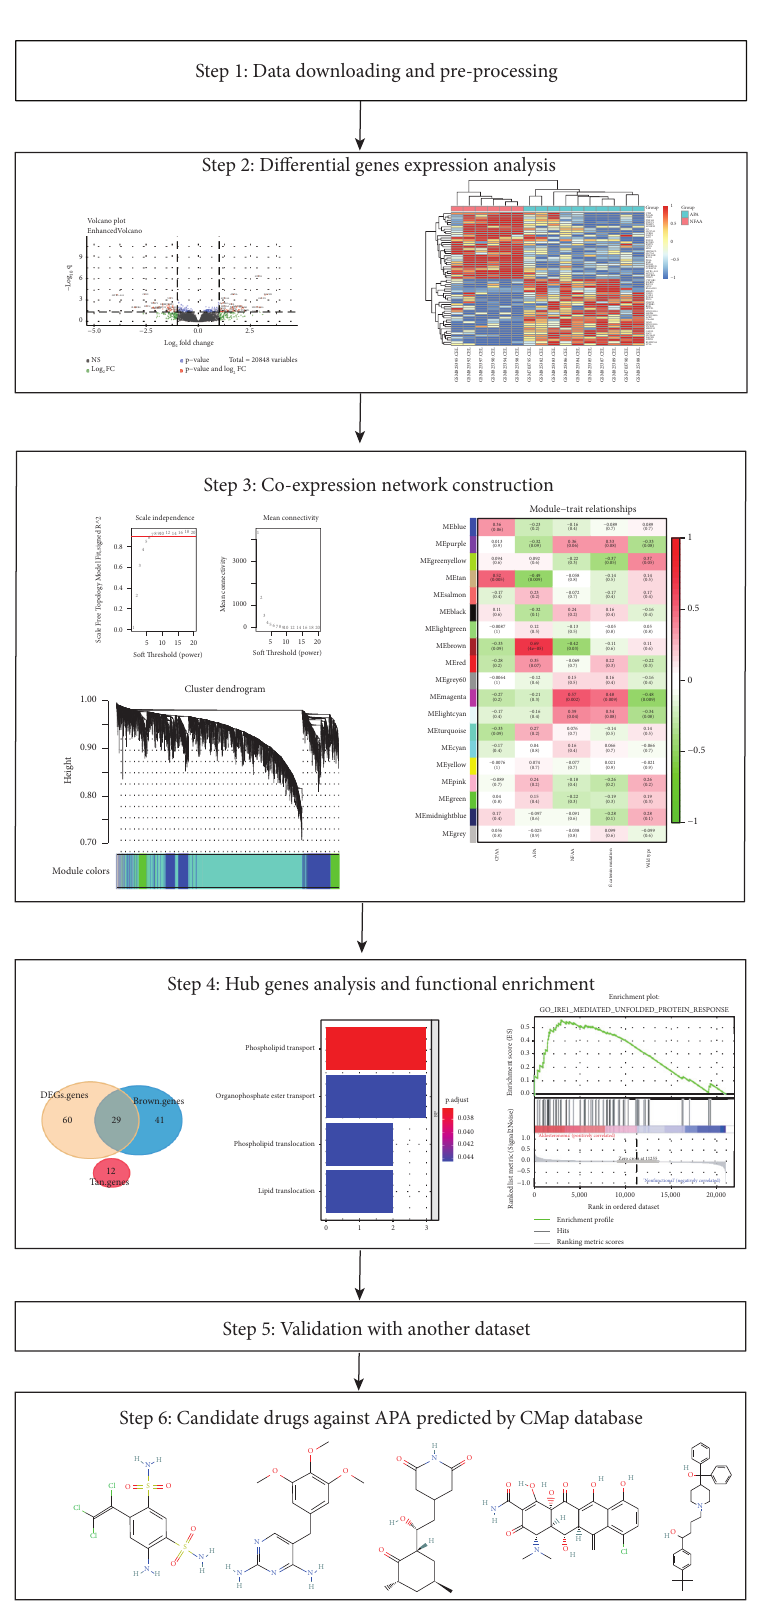
Figure 1: Workflow of the